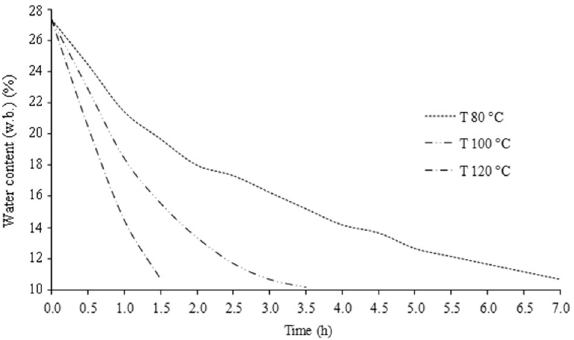
Figure 1. Drying curves of corn kernels at 80, 100, and 120 °C and airflow of 220 m 3 h −1